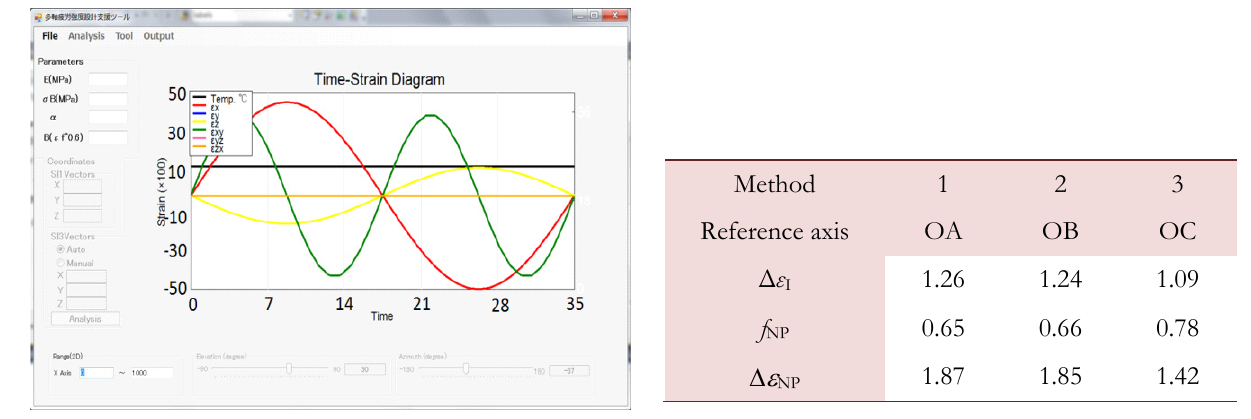
Figure 14: Strain waveforms of input data. Table 1: Comparison of evaluated parameters.